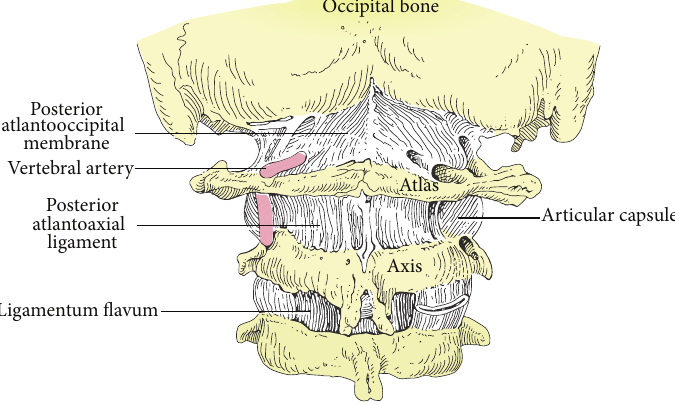
Figure 2: CCJ and suboccipital cavernous